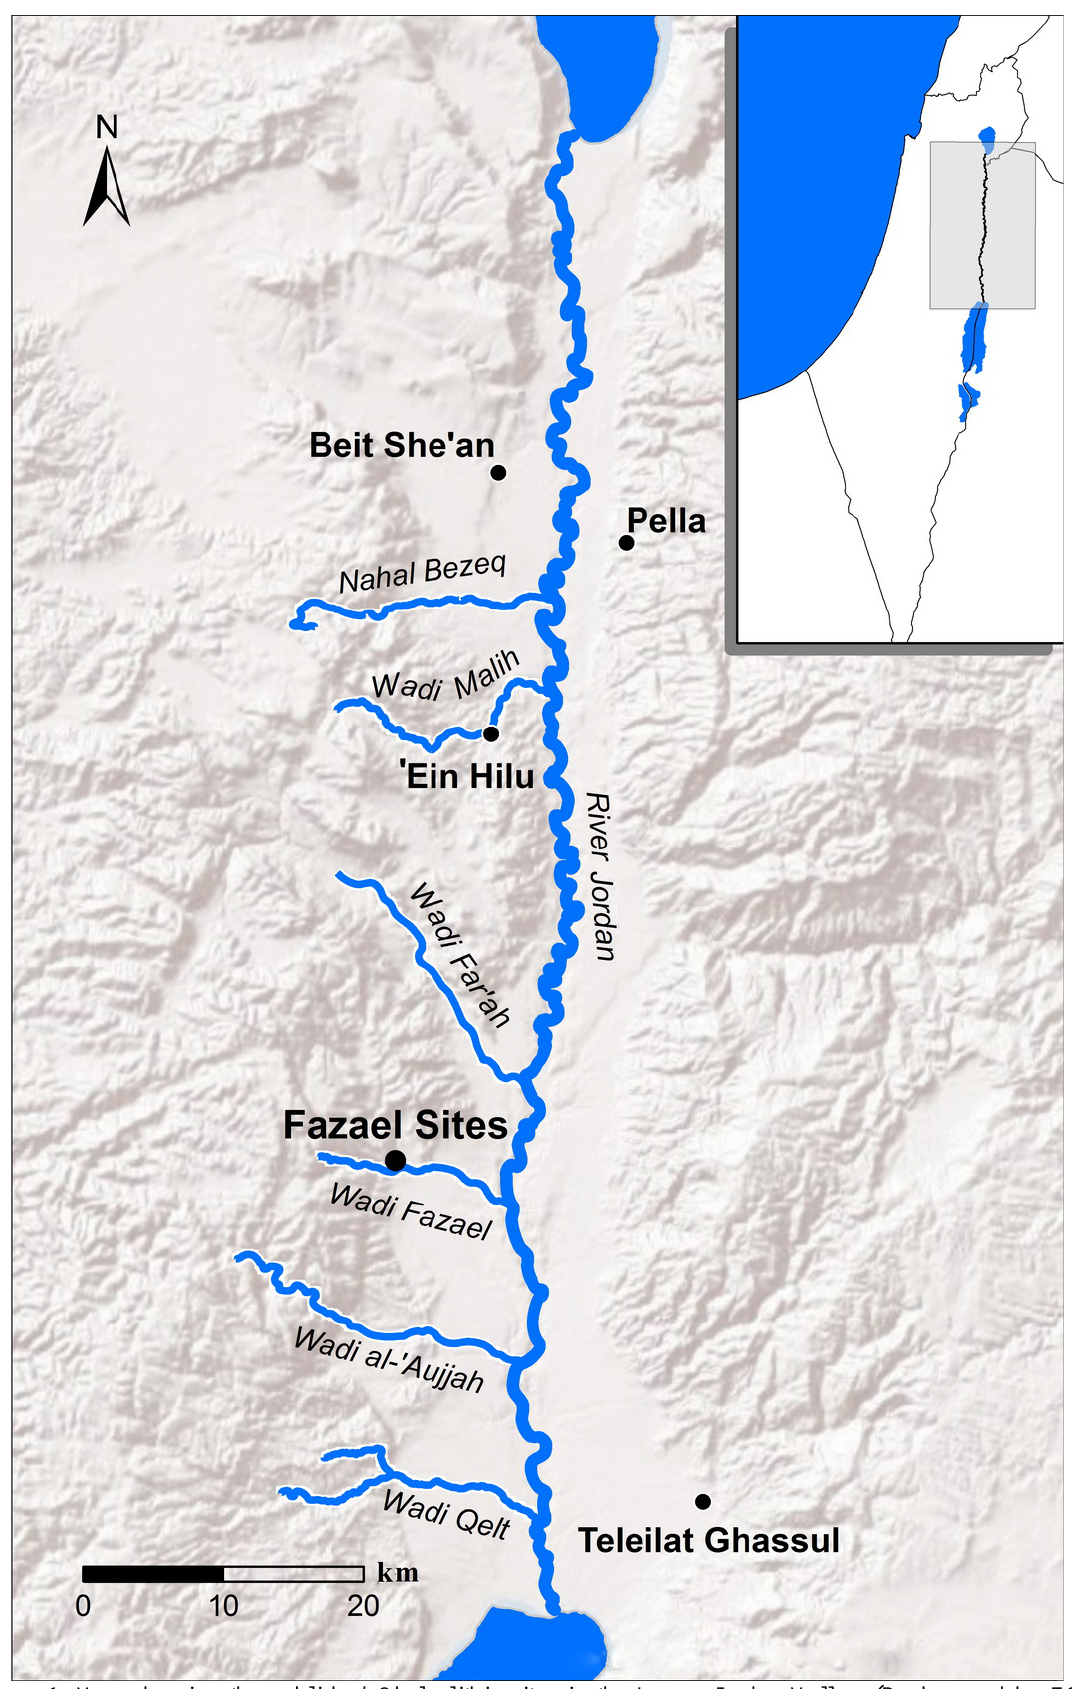
Figure 1. Map showing the published Chalcolithic sites in the Lower Jordan Valley. (Background by ESRI sources 2014: ESRI, USGS,